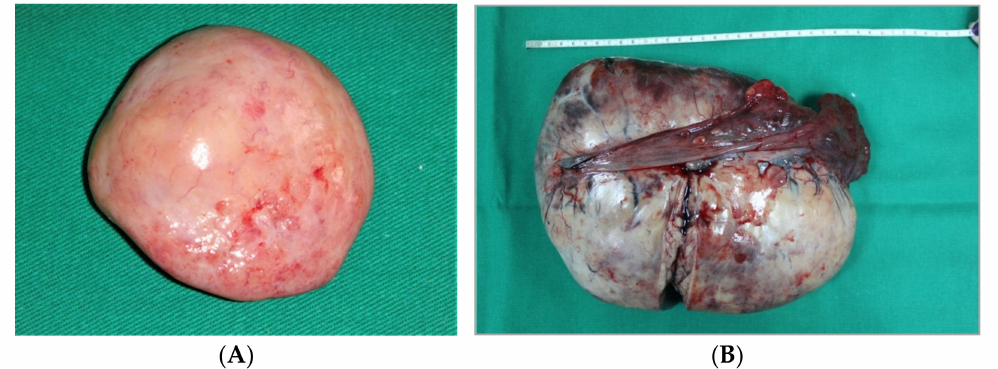
Figure 1. Dysgerminoma of the ovary ( A , B ). (Courtesy of Prof. G. Peltecu). Usually, dysgerminoma has a homogenous consistency on its cut surface, with rare exceptions when grossly visible calcifications are seen; this aspect suggests it is a go-